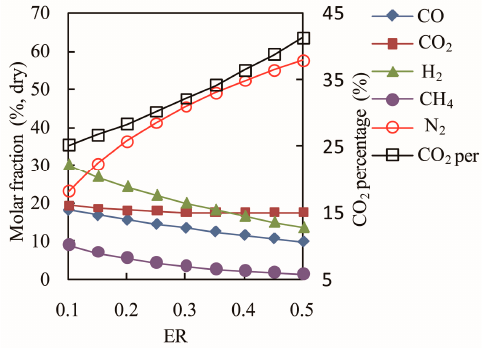
Figure 13. Effect of ER on syngas composition at T = 1100 K and SBR = 0.5.